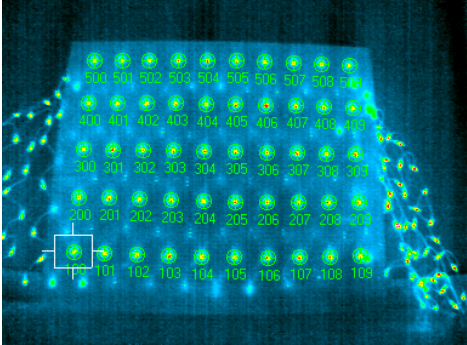
Figure 5: Captured thermal information for the planar testfield with lamps. The distortion of the thermal infrared image is clearly visible.